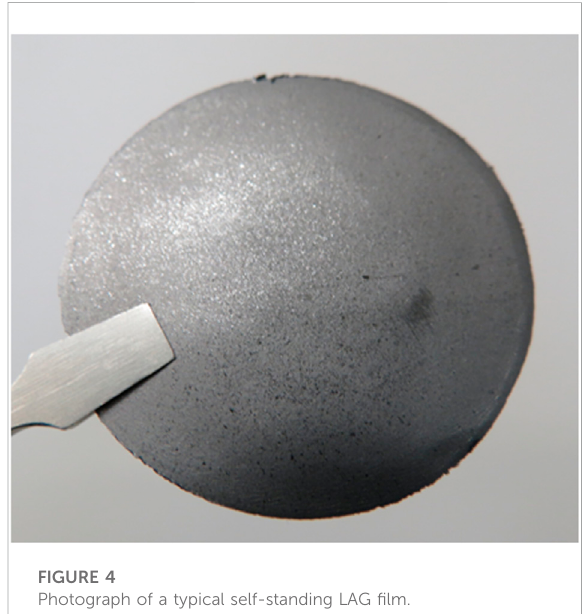
FIGURE 4 Photograph of a typical self-standing LAG fi lm.